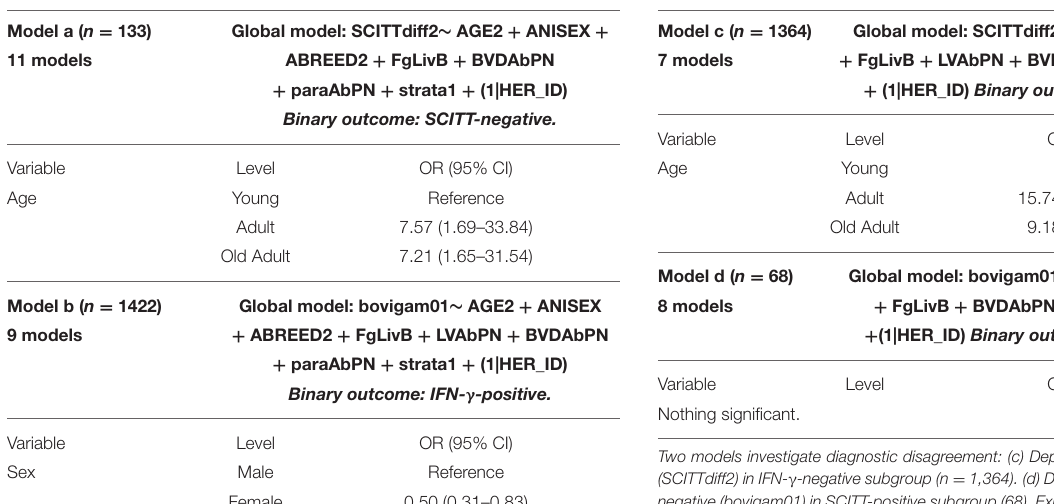
TABLE 3 | Final models to investigate risk factors for pastoral cattle testing IFN- γ assay-negative and